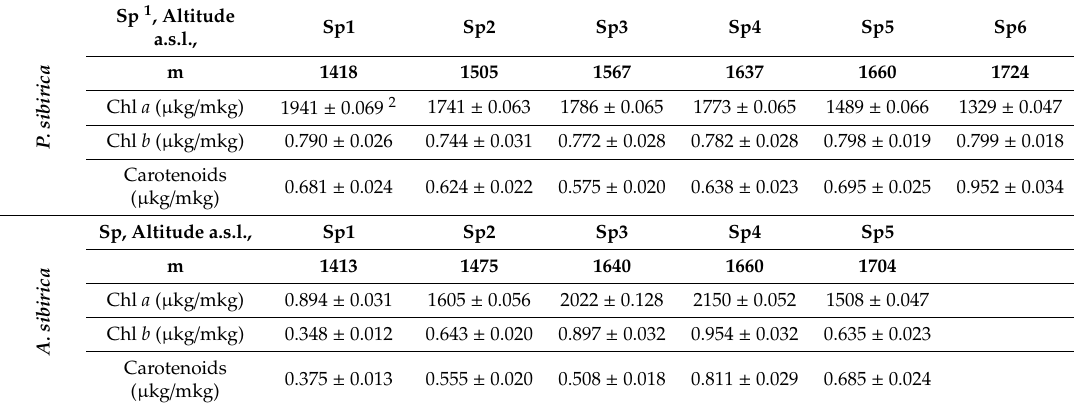
Table 1. A summary of the measured values of the pool of photosynthetic pigments at various s i P . altitudes in the vicinity of the timberline of West Sayan ridge. Sp = sample point, Chl = chlorophyll.